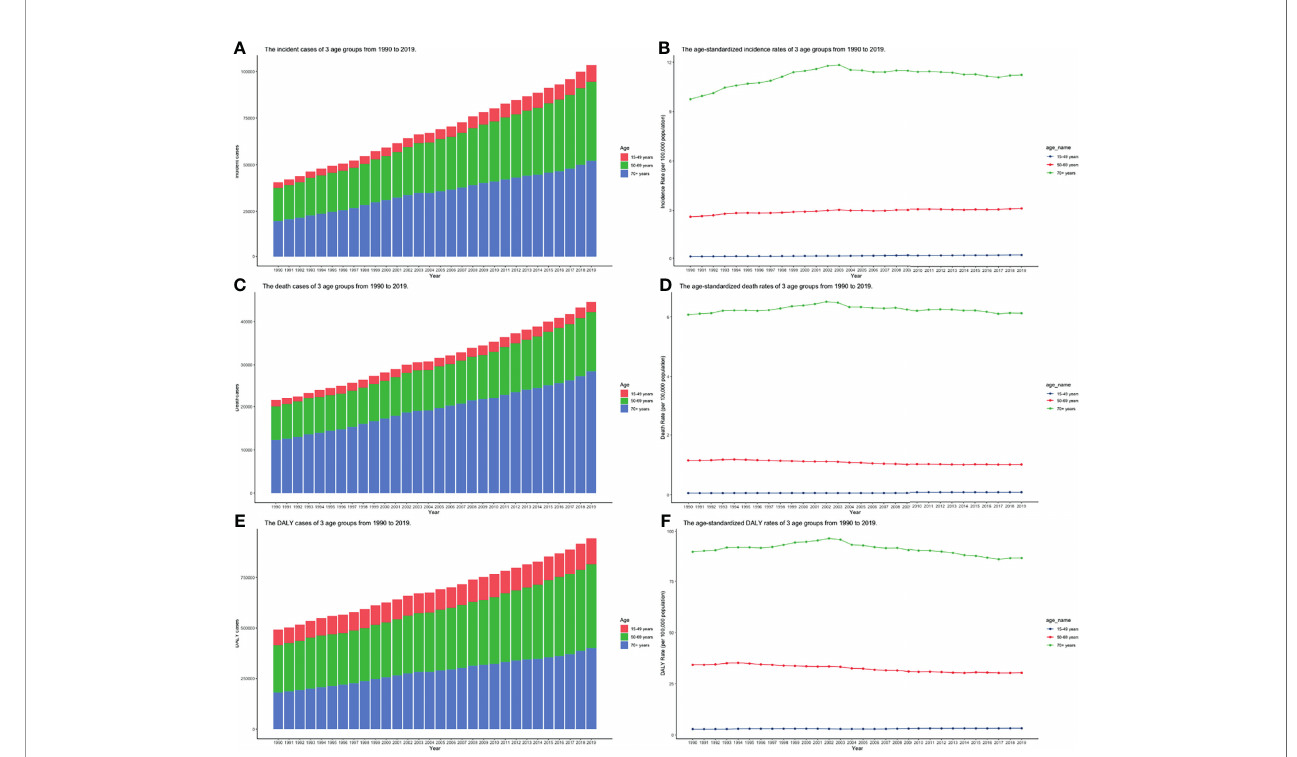
FIGURE 9 | The burden of incidence, deaths, and DALY of 3 age groups from 1990 to 2019. (A) Incident cases; (B) Incidence rates; (C) death cases; (D) death rates; (E) DALY rates; (F) DALYs (ASIR, age-standardized incidence rate; ASDR, age-standardized death rate; DALY, disability-adjusted life